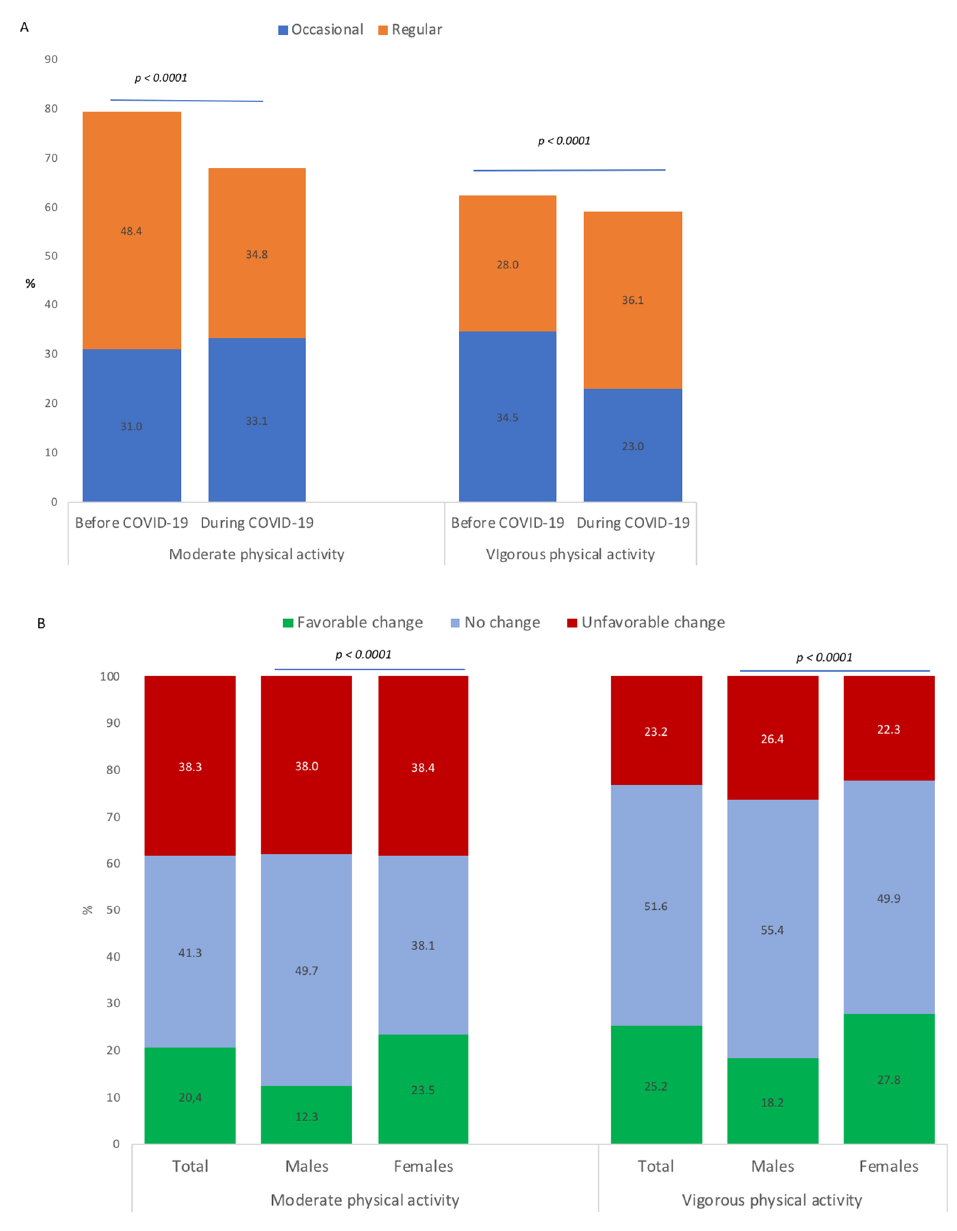
Figure 3. Moderate and vigorous physical activity of university students before and during COVID-19 ( A ) and changes in behavior between the periods before and during COVID-19 ( B ).